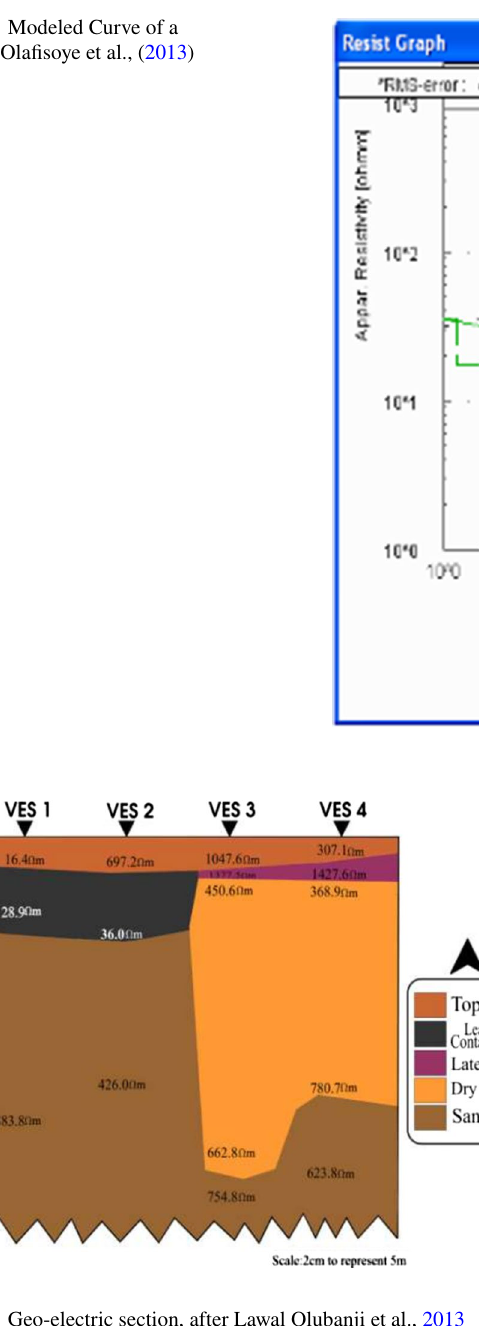
Fig. 2 Geo-electric section, after Lawal Olubanji et al.,